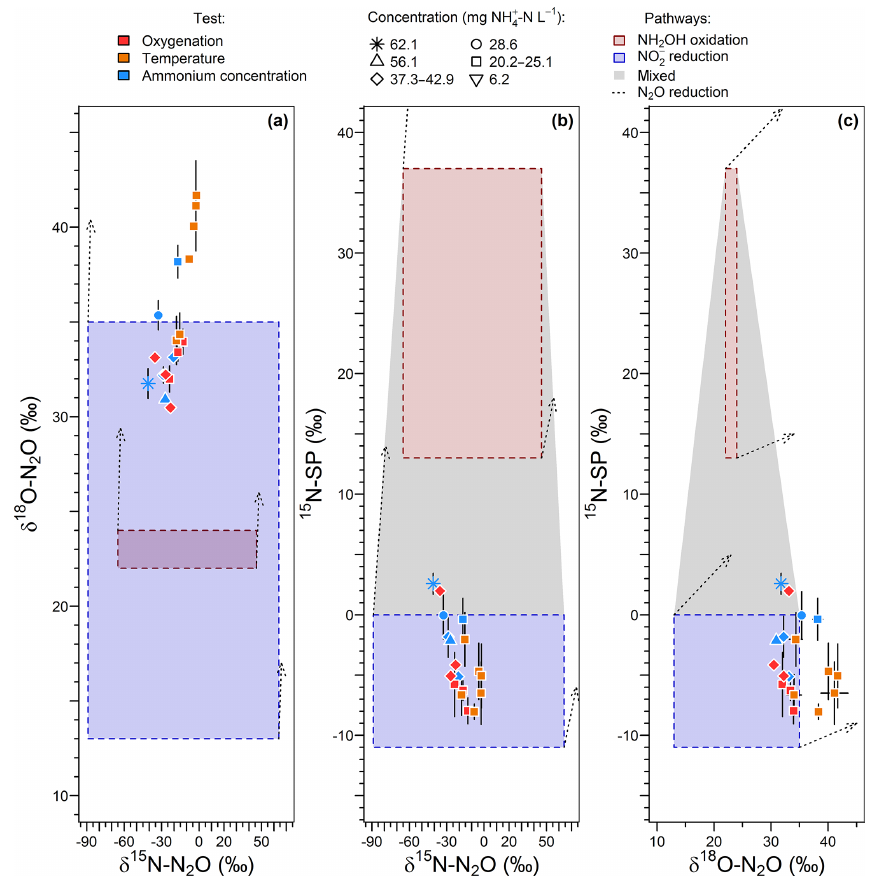
Figure 3. Interpretation maps of the isotope signature of N 2 O. Schematic maps of (a) δ 15 N- δ 18 O, (b) δ 15 N- 15 N-SP and (c) δ 18 O- 15 N-SP. The red and blue squares show the range of the data for N 2 O produced by “hydroxylamine oxidation” and “nitrite reduction”, respectively. The shaded area represents mixing of N 2 O produced by these pathways. The N 2 O reduction increases δ 15 N, δ 18 O and 15 N-SP with slopes characterizing the pairwise